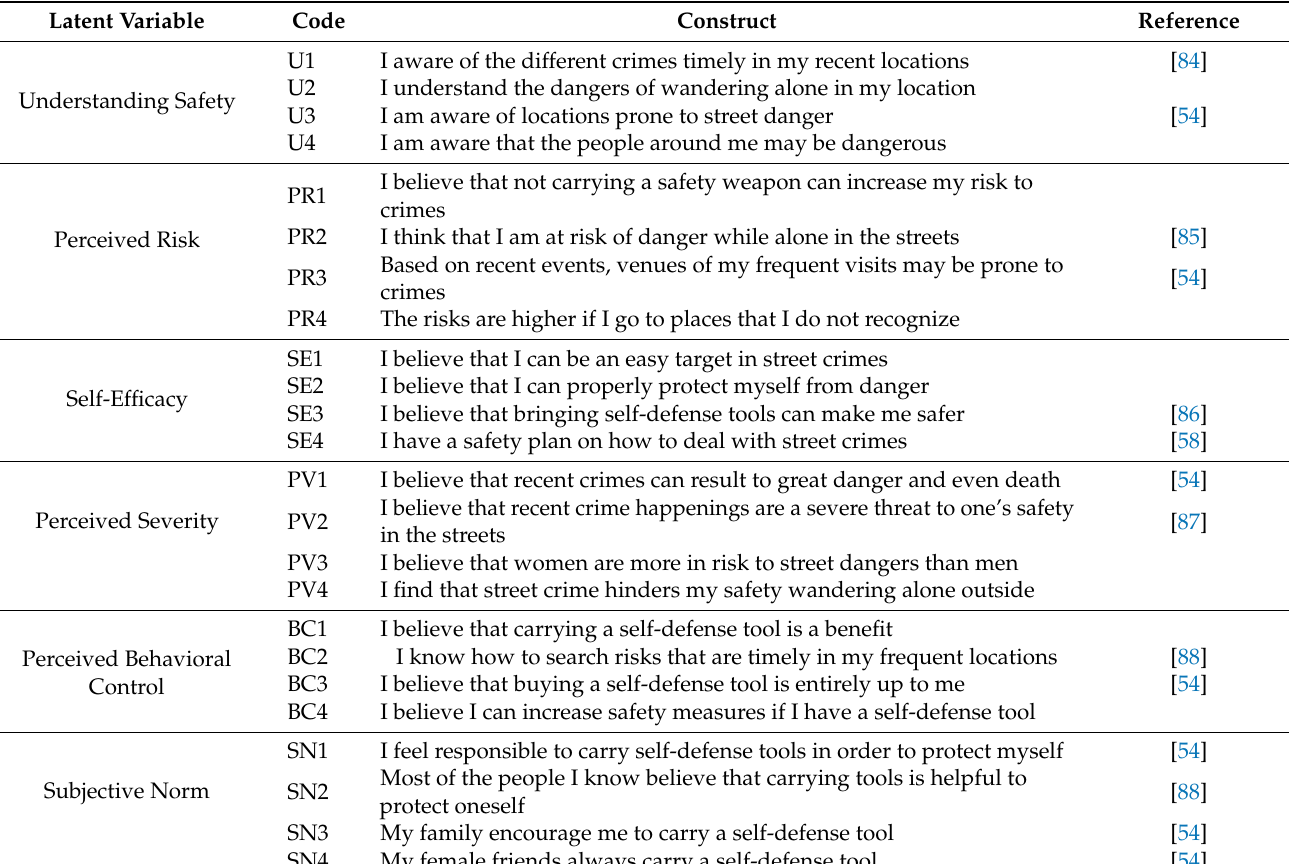
Table 3. The variables and